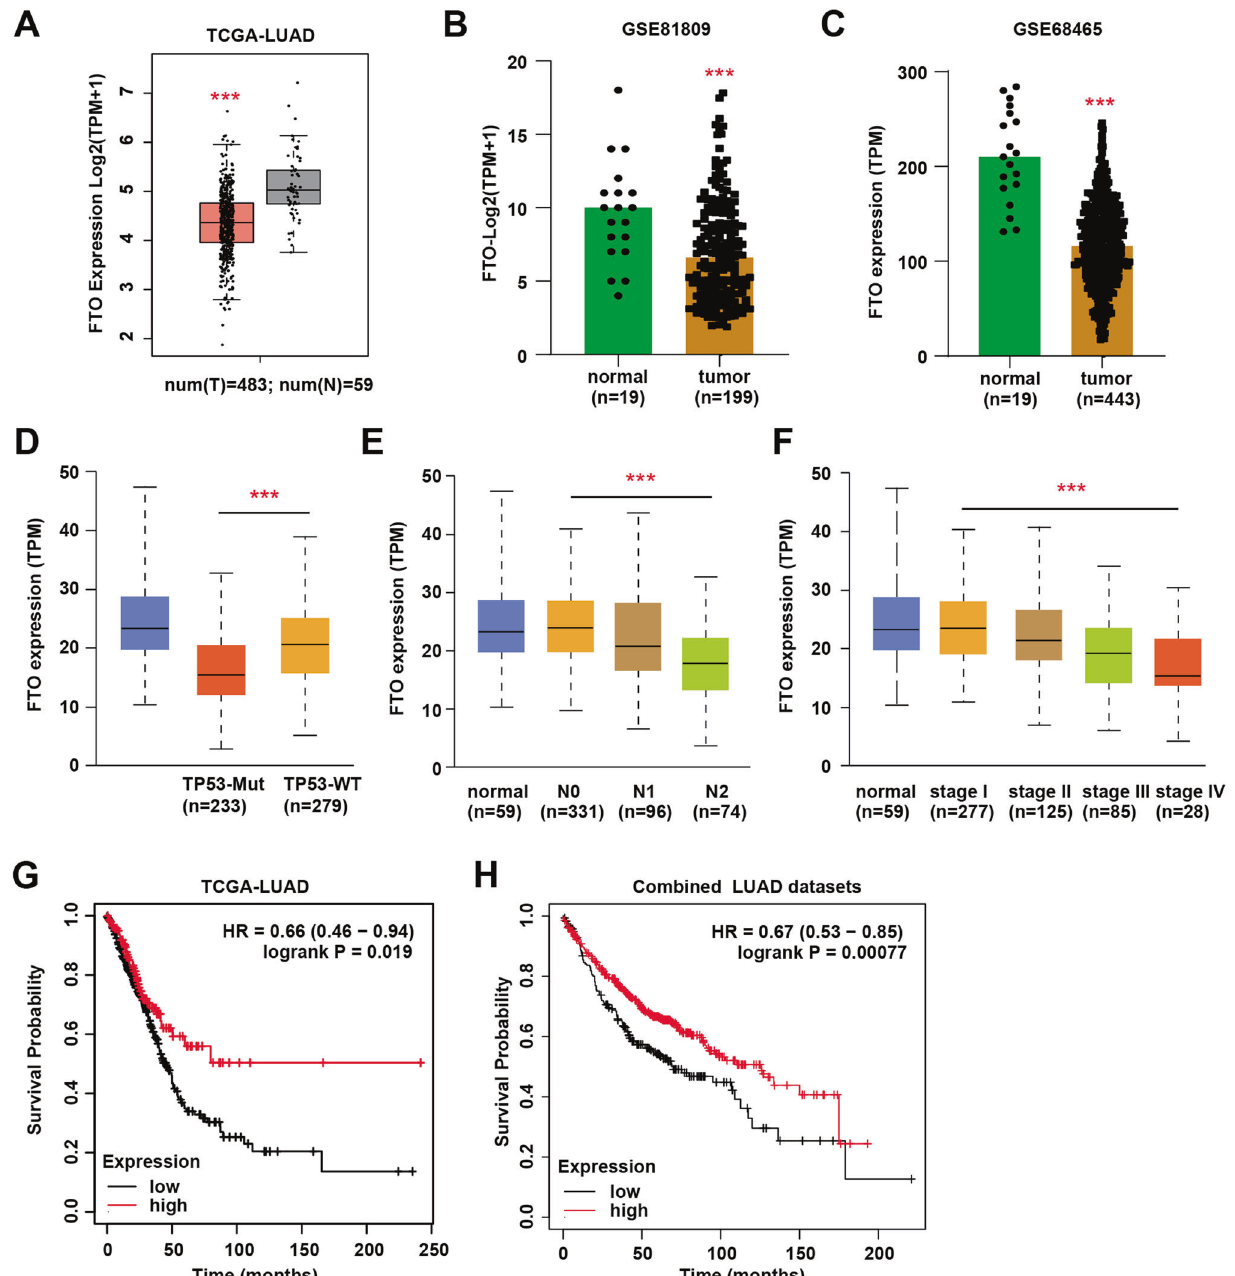
Fig. 4 FTO was down-regulated in LUAD samples and associated with clinical signi fi cance in LUAD patients. A Box plot showing the differential FTO mRNA levels in normal and tumor samples. B Differential analysis of FTO levels in normal and tumor samples based on GSE81809 dataset. C Differential analysis of FTO levels in normal and tumor samples based on GSE68465 dataset. D – F Correlation analysis showing the underlying relationships between FTO levels and clinical phenotypes, including TP53-mutation status ( D ), lymphatic metastasis ( E ) and clinicalpathological stages ( F ). G – H Kaplan – Meier analysis with log-rank test showed that patients with low FTO had poorer OS outcomes relative to those with high FTO expressions based on TCGA-LUAD cohort ( G ) and combined pan-LUAD datasets ( H ). Bar = Mean ± SD. * P < 0.05, ** P < 0.01, *** P <